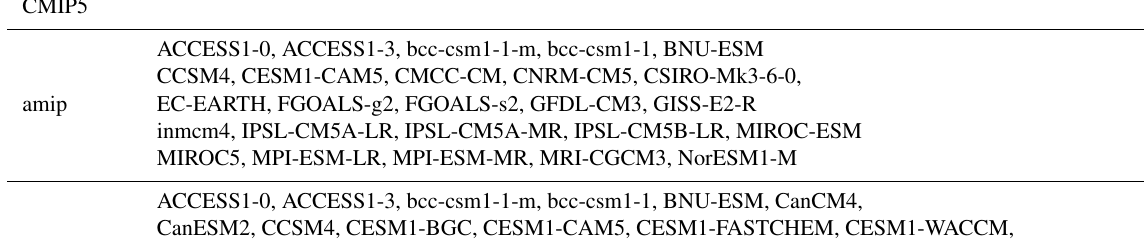
Table A1. CMIP5 and CMIP6 models considered in this